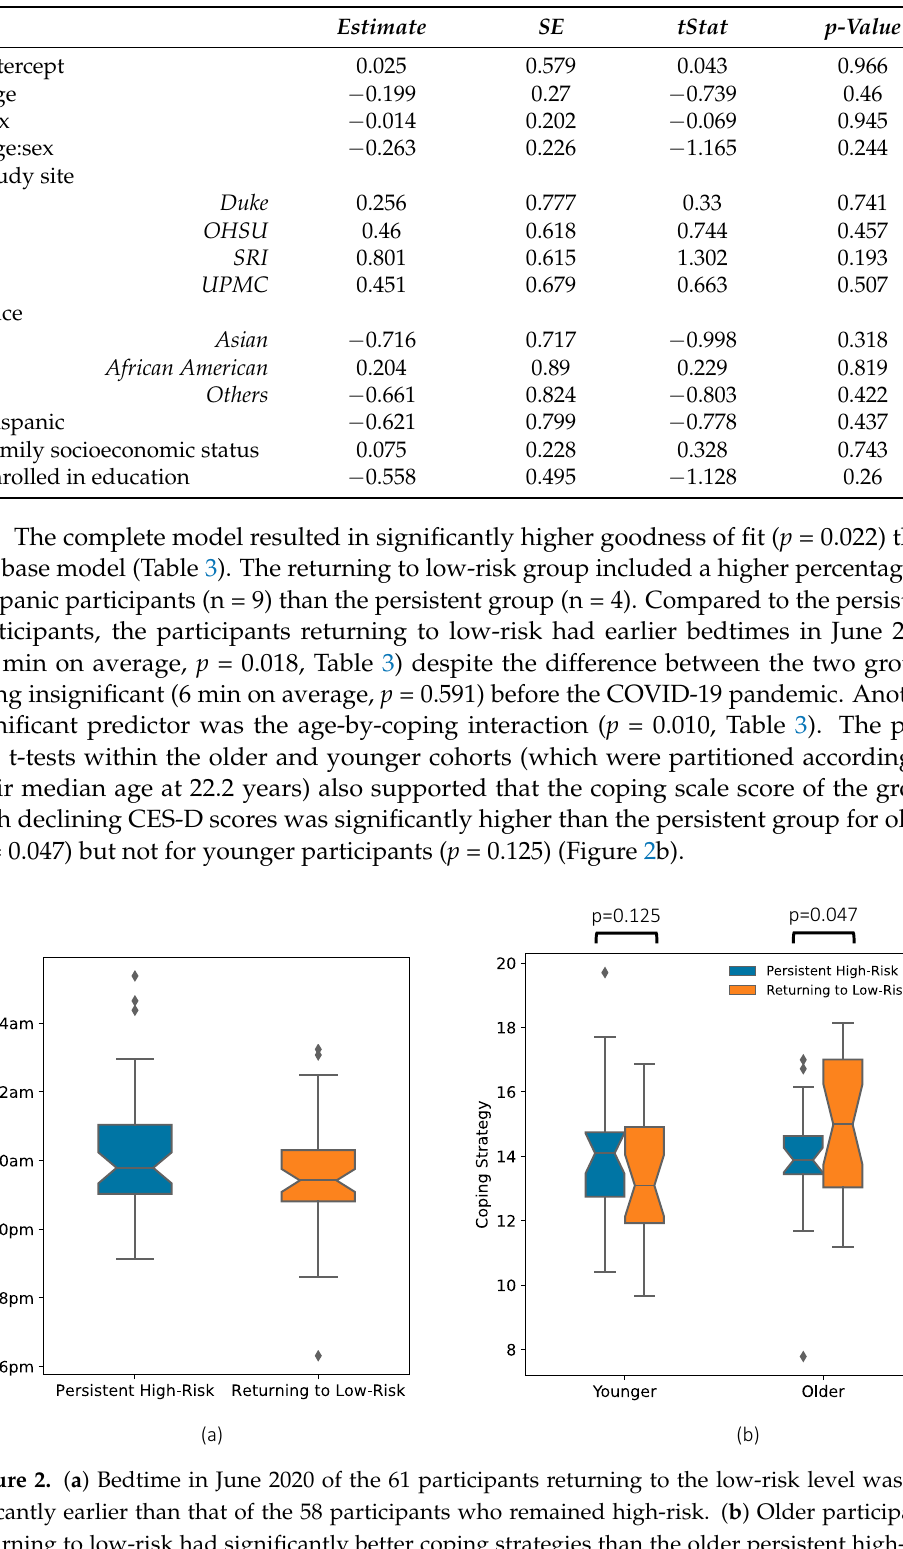
Table 2. Results of the base logistic regression model applied to the 119 participants who exceeded the depression threshold in June 2020.